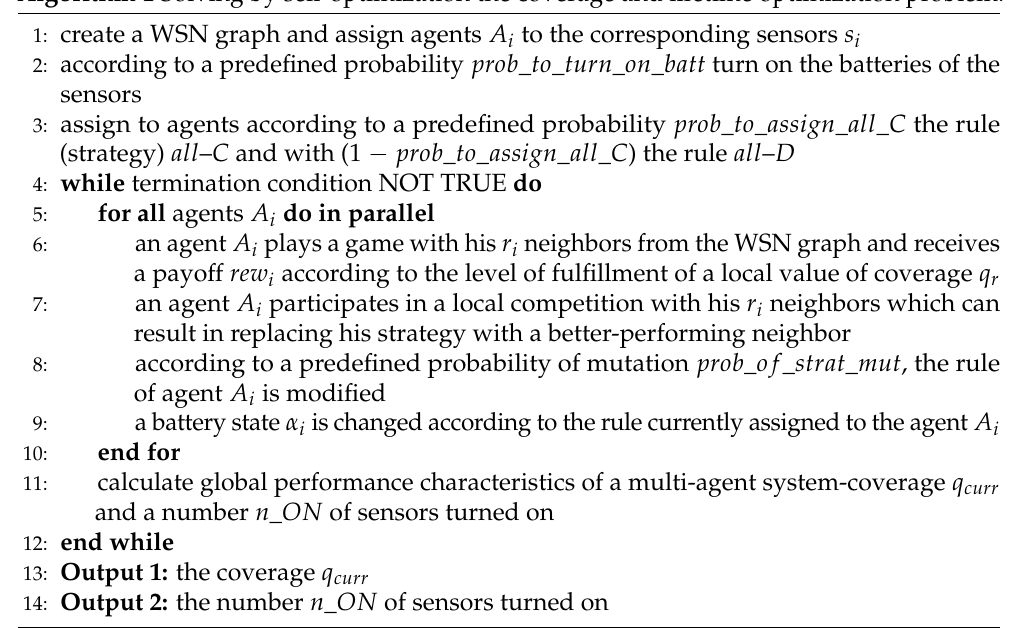
Algorithm 1 Solving by self-optimization the coverage and lifetime optimization